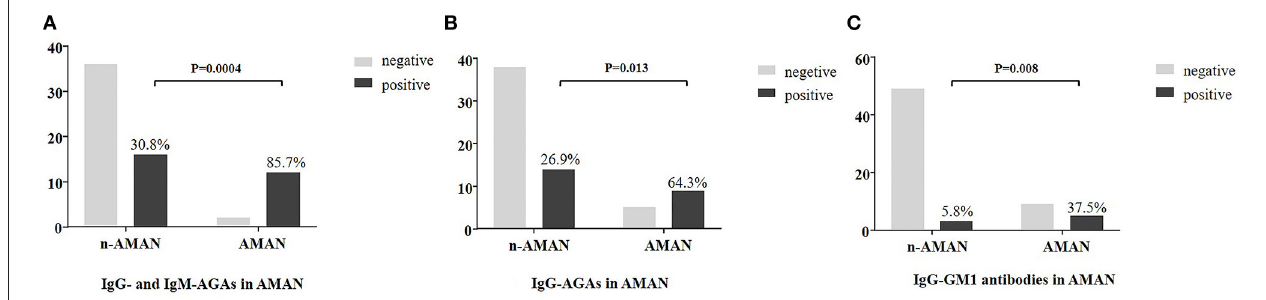
FIGURE 3 | Plasma anti-ganglioside antibodies frequency in AMAN and non-AMAN patients. Frequency of anti-ganglioside antibodies is shown in the histogram. Comparison analysis was performed between AMAN and non-AMAN patients with chi-squared test. (A) AGAs (IgG or IgM antibodies against GM1, GM2, GM3, GM4,